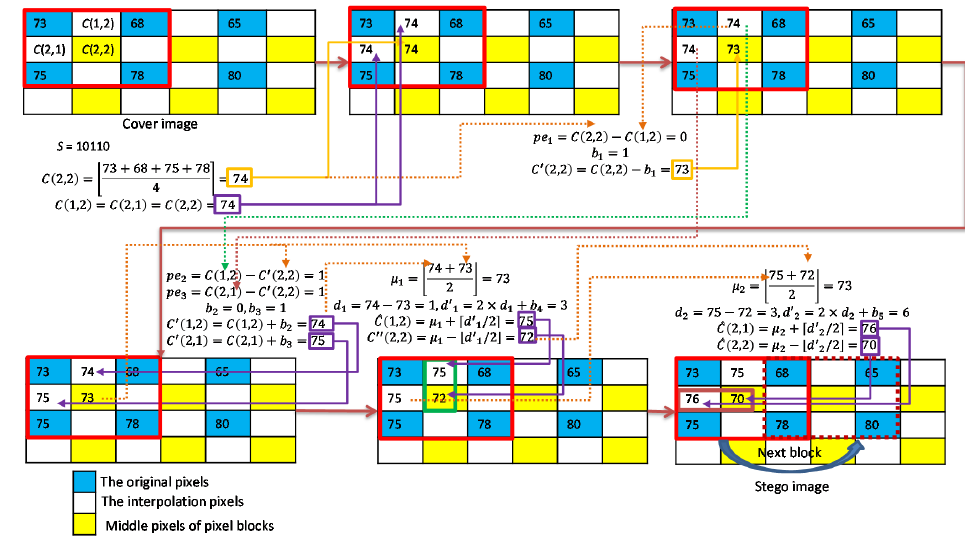
Figure 6. Example of interpolation and data embedding for complex blocks.